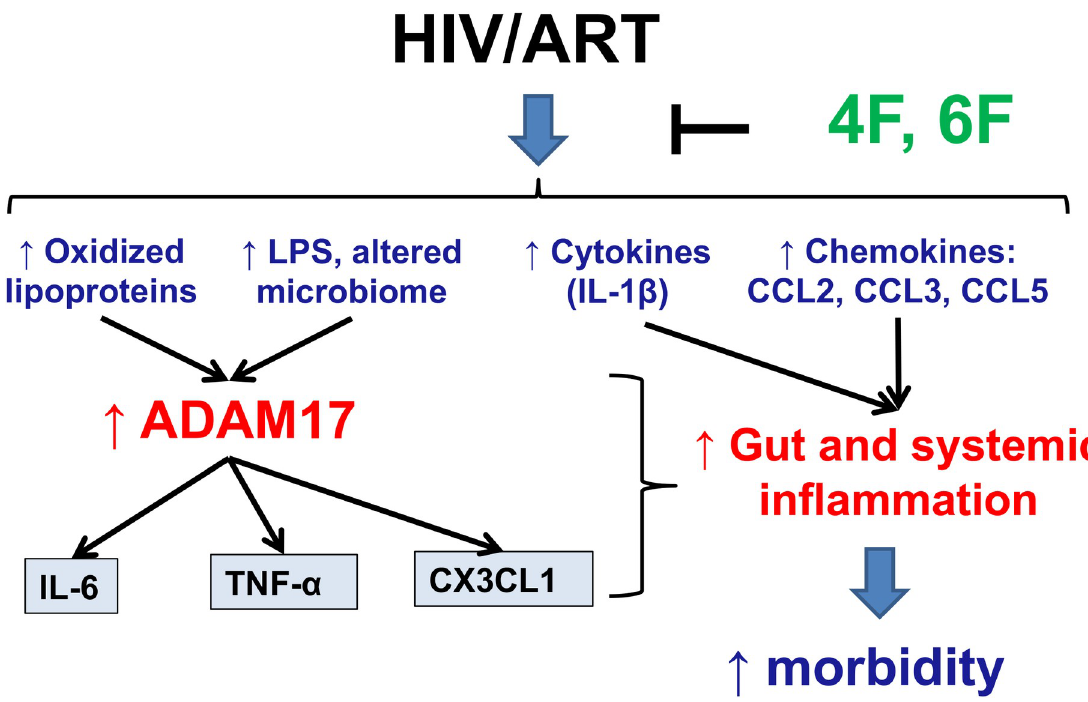
Fig 8. Overall Hypothesis. Systemic and intestinal levels of endotoxin (LPS) and oxidized lipoproteins (oxidized high- and low-density lipoproteins; HDLox and LDLox) are increased in chronic treated HIV despite potent antiretroviral therapy (ART). Oxidized lipoproteins and LPS increase protein levels of A disintegrin and metalloprotease 17 (ADAM17) in intestinal myeloid, epithelial and endothelial cells and protein levels of cytokines [interleukin (IL)-6, tumor necrosis factor alpha (TNF- α )] and chemokines [C-X3-C Motif Chemokine Ligand 1 (CX3CL1)], that are mediated by ADAM17 sheddase activity. ApoA-I mimetic peptides (4F, 6F) act mostly in the intestine and reduce levels of oxidized lipoproteins, LPS and microbial translocation, leading to reduction in levels of ADAM17 and secreted products of its sheddase activity (IL-6, TNF- α , CX3CL1). ApoA-I mimetic peptides (4F, 6F) also reduce other proinflammatory cytokines (IL-1 β ) and chemokines (CCL2, CCL3, CCL5) in blood and the intestine and ultimately reduce increased gut and systemic inflammation and morbidity in chronic treated